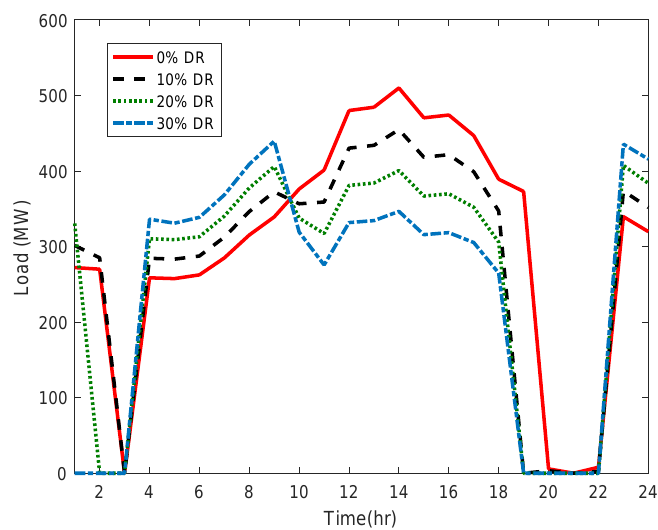
Figure 7. The power purchased from the day-ahead electricity market.